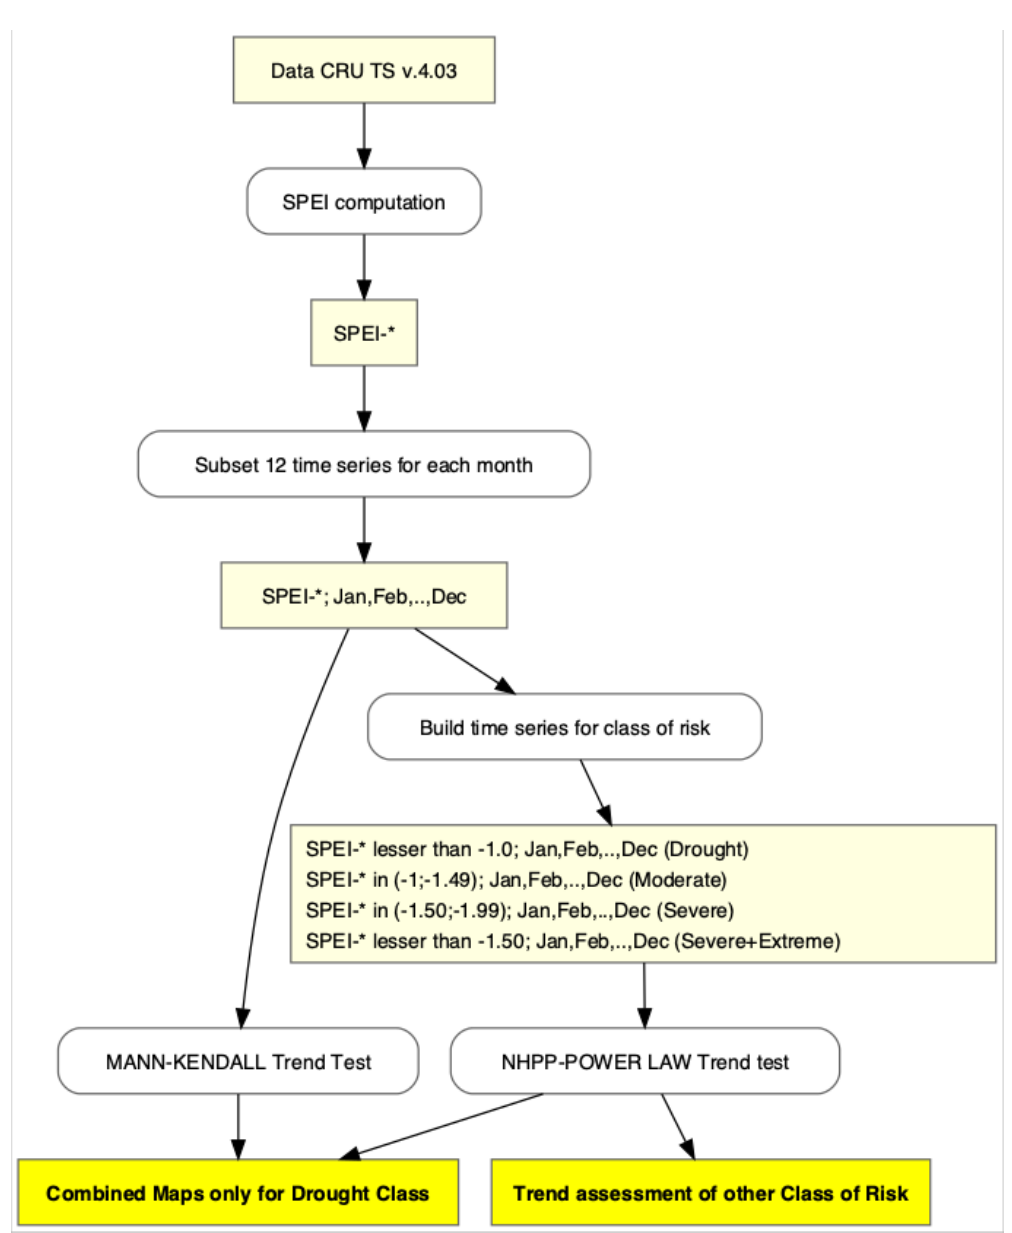
Figure 1. Technical flow chart for the proposed method (the asterisk symbol refers to the different scale of aggregation used for the SPEI